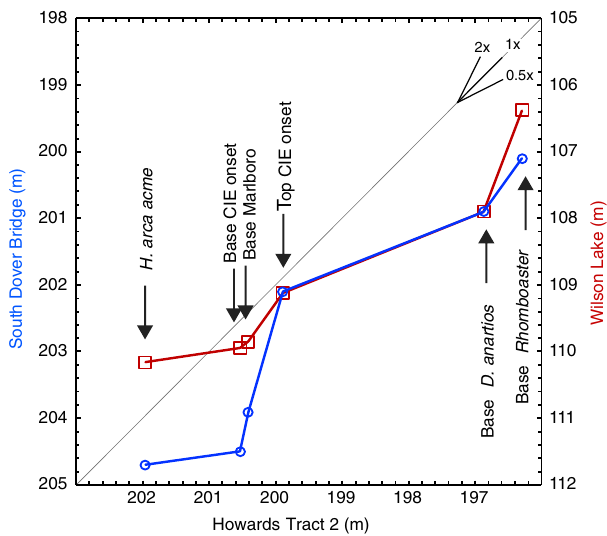
Fig.5|Comparisonofthecarbonisotopeexcursion(CIE)onsetwiththebaseof theMarlboroClayaswellasthreenannoplanktondatums. Blue:HowardsTract 2versusSouthDoverBridge(left);Red:HowardsTract2versusWilsonLake(right). See Supplementary Information for details and